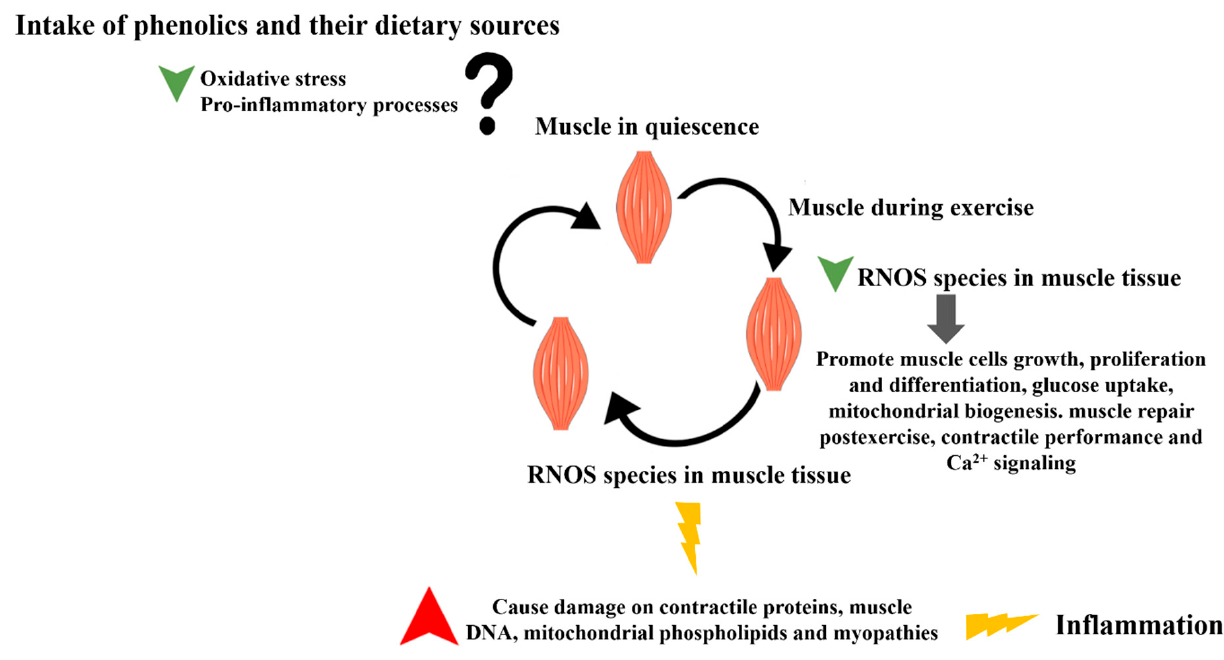
Figure 5. Possible effects of phenolics on athletes and healthcare practitioners’ performance and recovery.